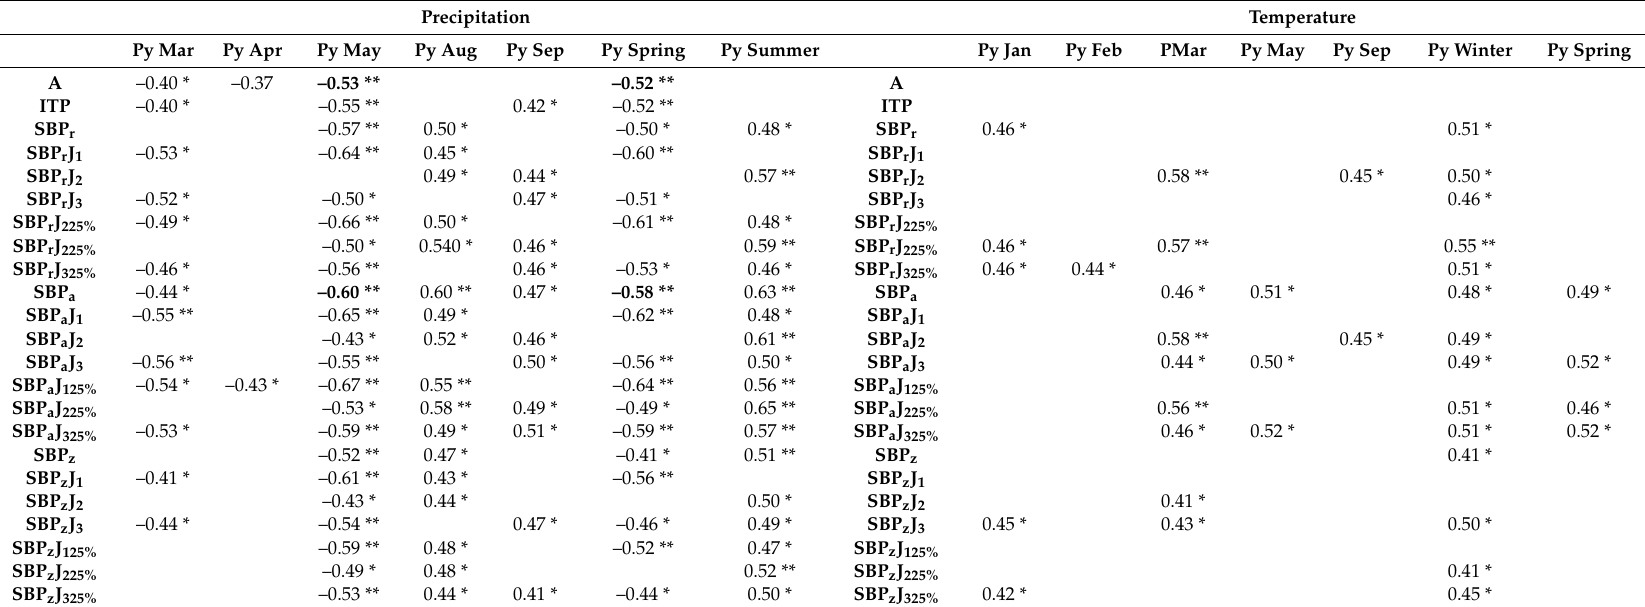
Table 3. Significant climate- δ 18 O correlation of various chronologies during the previous